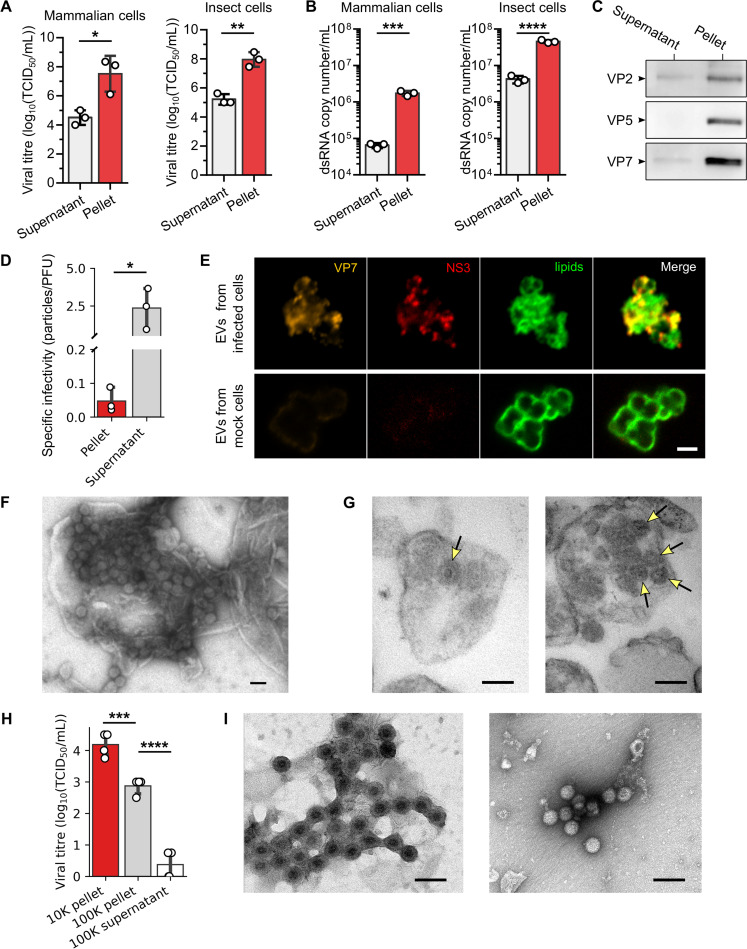
The majority of BTV virus particles are released in large EVs.(A and B) Virus particles titration (A) and viral genome quantification (B) in the pellet or in the supernatant after isolation of EVs secreted by infected mammalian sheep cells and insect cells. Data are presented as mean ± SD. Each point indicates the value of independent replicates (N = 3; unpaired t-test, *p<0.05, **p<0.01, ***p<0.001, ****p<0.0001). (C) Outer capsid proteins VP2 and VP5, and inner capsid protein VP7, detected in the pellet and supernatant after isolation of EVs secreted by infected mammalian cells. (D) Specific infectivity, which is the number of genome copies per plaque forming unit, measured for virus particles in the pellet and the supernatant after a 10,000xg centrifugation. Data are presented as mean ± SD. Each point indicates the value of independent replicates (N = 3; unpaired t-test, *p<0.05). (E) Immunofluorescence microscopy images of purified EVs secreted from infected (two top rows) or mock (bottom row) mammalian cells labelled with anti VP7 (orange) and NS3 (red) antibodies, and a fluorescent lipid membrane marker (green). Scale bar: 2 μm. (F and G) Electron microscopy images of whole EVs (F) and sectioned EVs (G) secreted from infected mammalian cells. Yellow arrows indicate the virus particles positions in the sections. Scale bar: 100nm. (H) Virus particles titration in the pellets and the final supernatant after centrifugation of 10,000xg and 100,000xg. Data are presented as mean ± SD. Each point indicates the value of independent replicates (N = 3; unpaired t-test, ****p<0.0001). (I) Representative electron microscopy images of BTV particles observed in the 100,000xg pellet. Scale bar: 100nm.